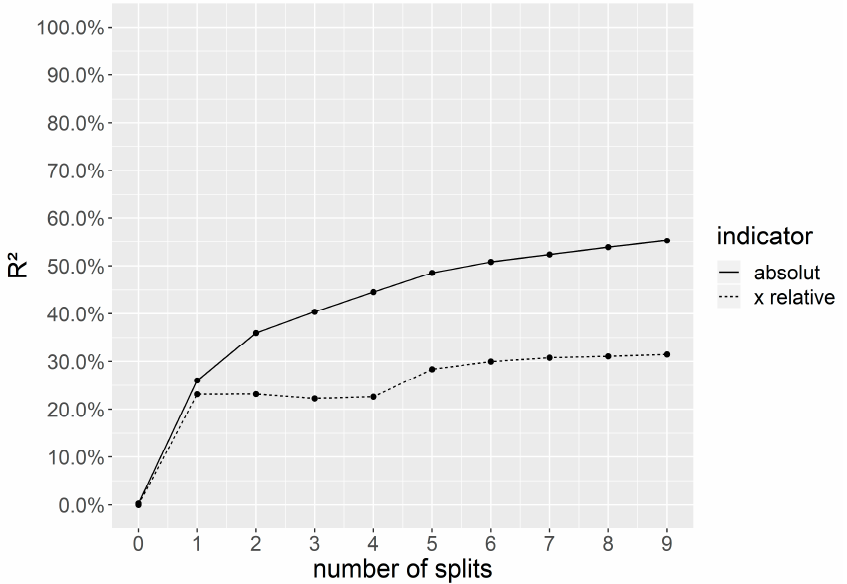
Figure 1. Determination of splits.